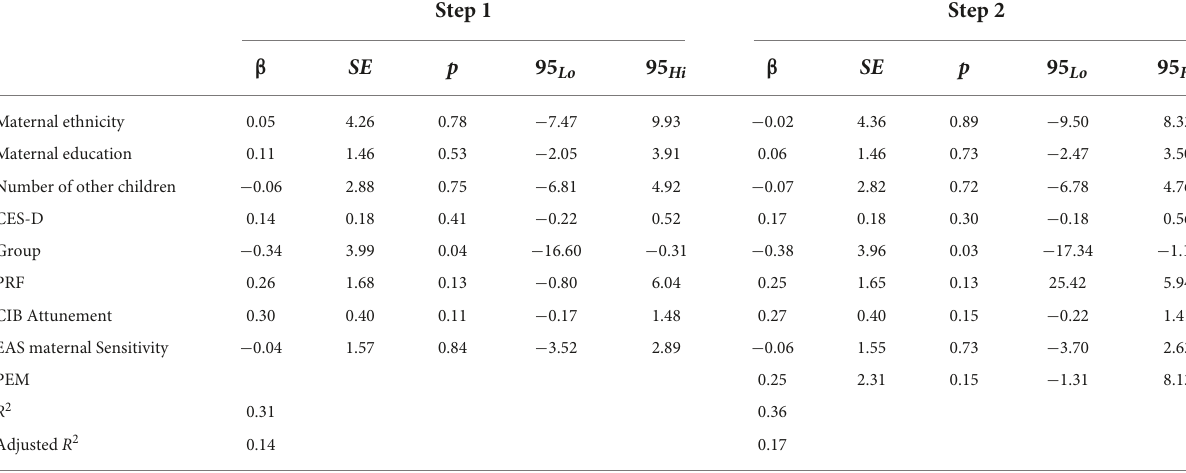
TABLE 3 Standardized regression coefficients for infants’ cognitive development scores regressed on background variables.